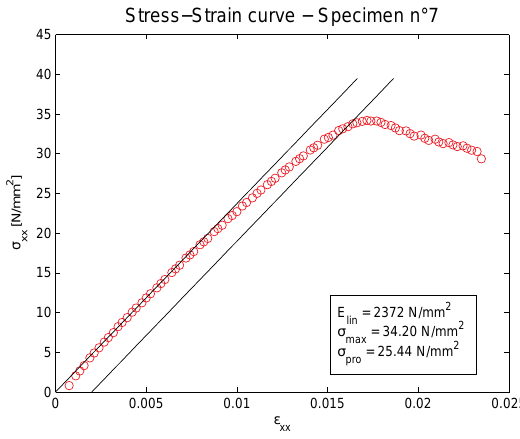
Figure 17: Actual stress-strain curve for specimen 7.